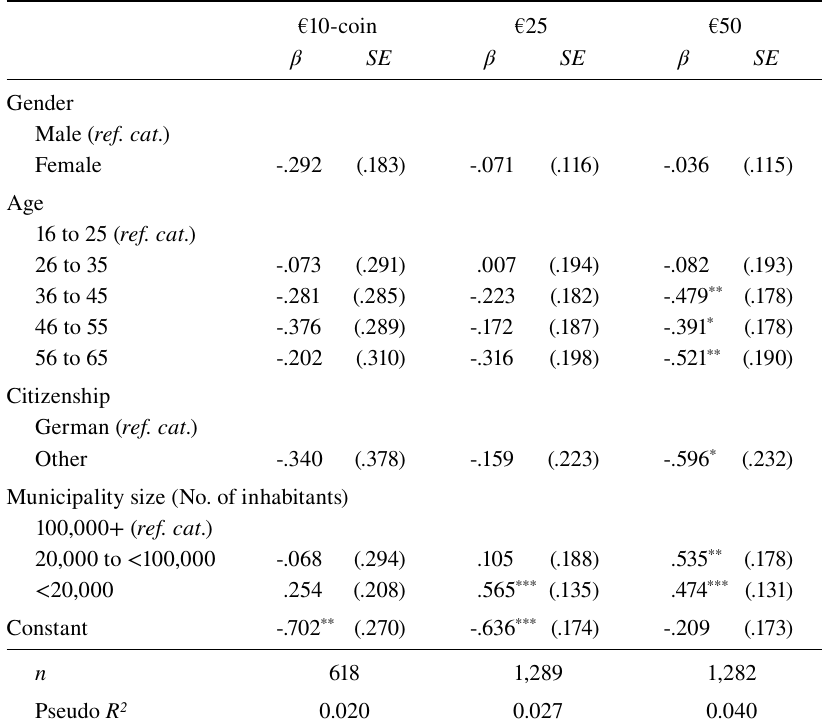
Logistic regression of response behavior on frame variables for each incentive